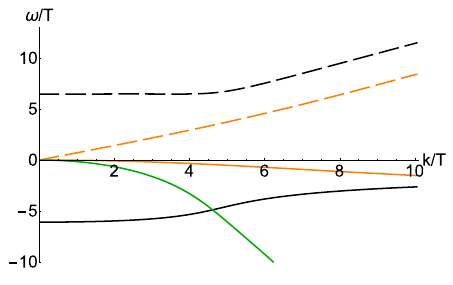
Figure 7 . The lowest QNMs in a (cid:22)=T (cid:25) 5 RN background. The dashed lines are the real parts of !=T , while the solid lines are the imag- inary parts. The real part of the green mode coincides with the horizontal